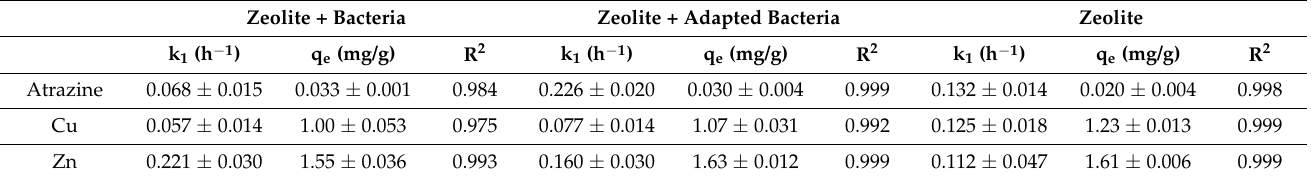
Table 2. Pseudo-first order model fittings for the biosorption/adsorption of atrazine, Cu and Zn for the different sorption systems in study.